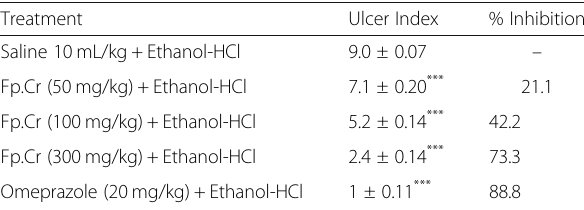
Table 2 Protective effect of Ficus palmata crude extract (Fp.Cr) and omeprazole against ethanol-HCl induced gastric ulcers in rats Treatment Ulcer